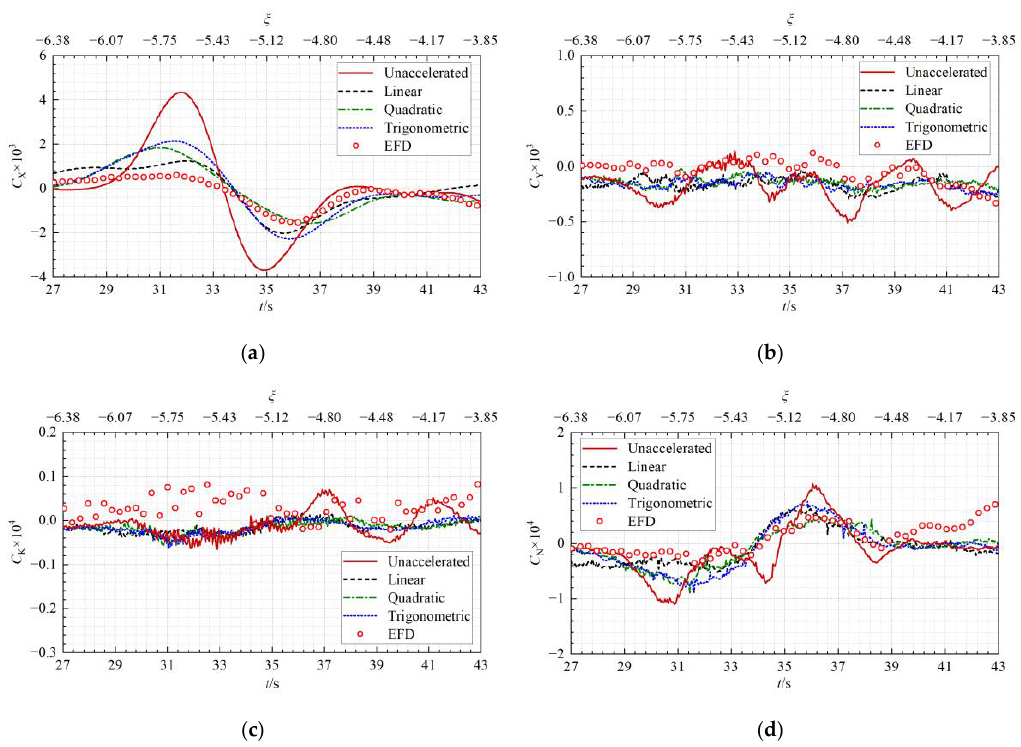
Figure 10. Time histories of attitudes of the moored ship under the impacts of the solitary wave system. ( a ) Sinkage’, ( b ) Trim’.